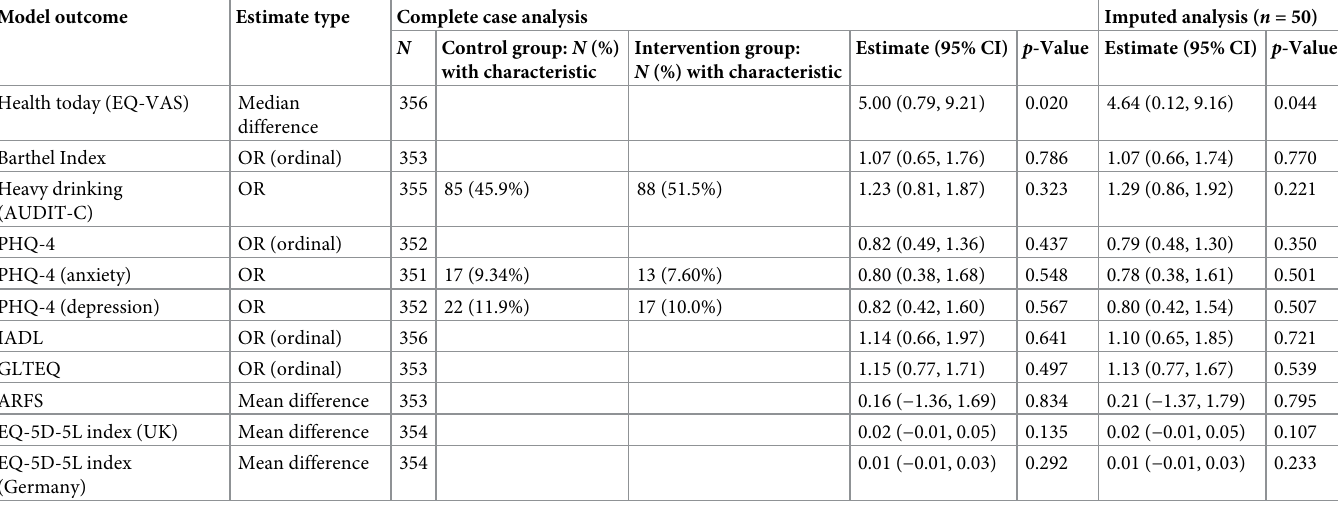
Table 3. Regression analysis results for primary and secondary outcomes: Complete case and imputation